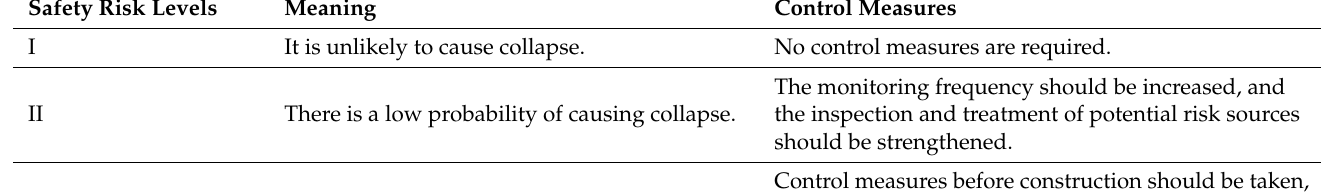
Table 5. Control measures under different safety risk levels.